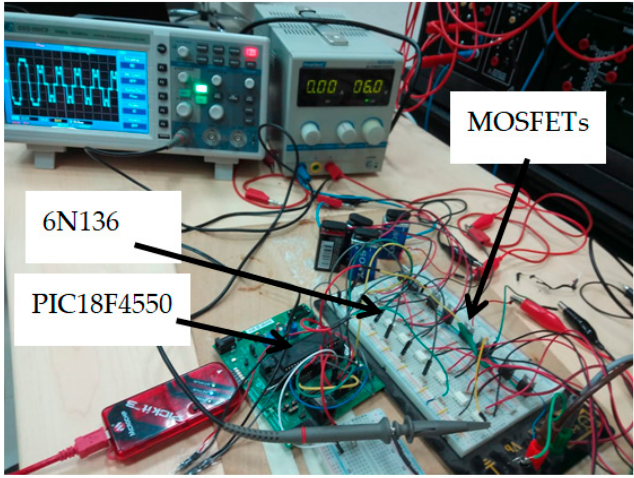
Figure 5. Experimental setup of the proposed system.